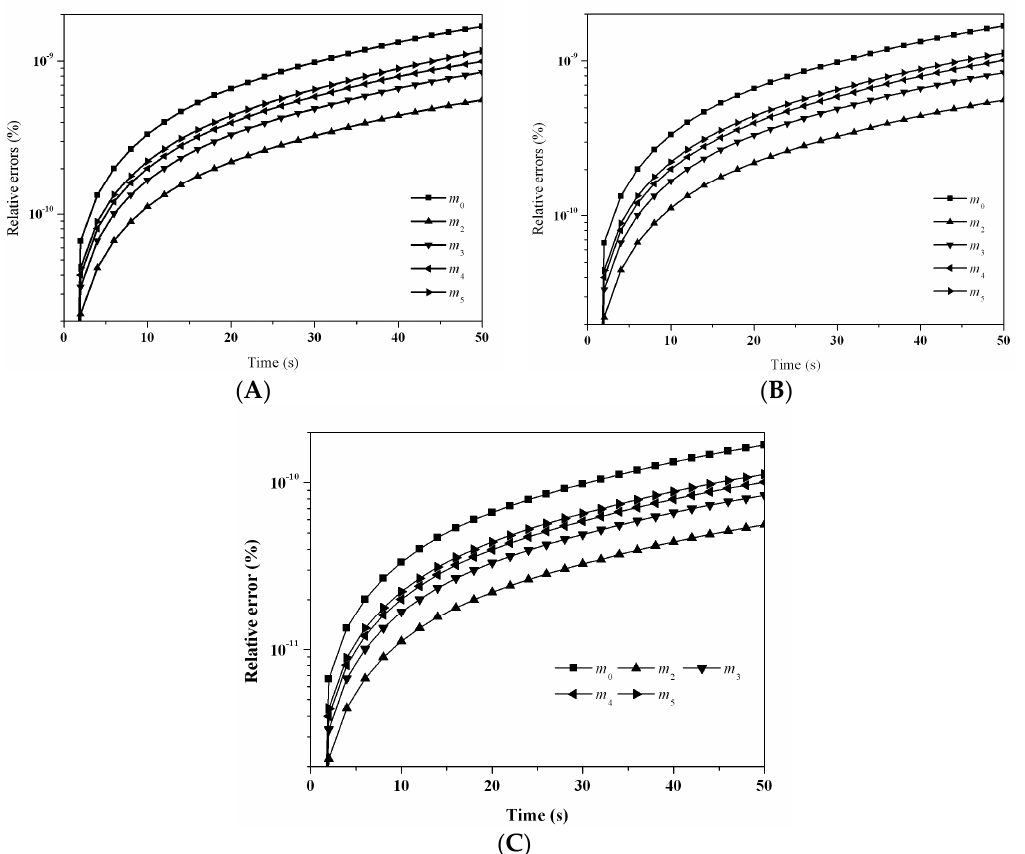
Figure 13. Evolution of relative errors for the pure breakage process with constant kernel, exponential initial PSD, and uniform daughter distribution with: ( A ) LFPQMOM; ( B ) QMOM; and ( C ) FPQMOM (square: m 0 ; up triangle: m 2 ; down triangle: m 3 ; left triangle: m 4 ; right triangle: m 5 ).